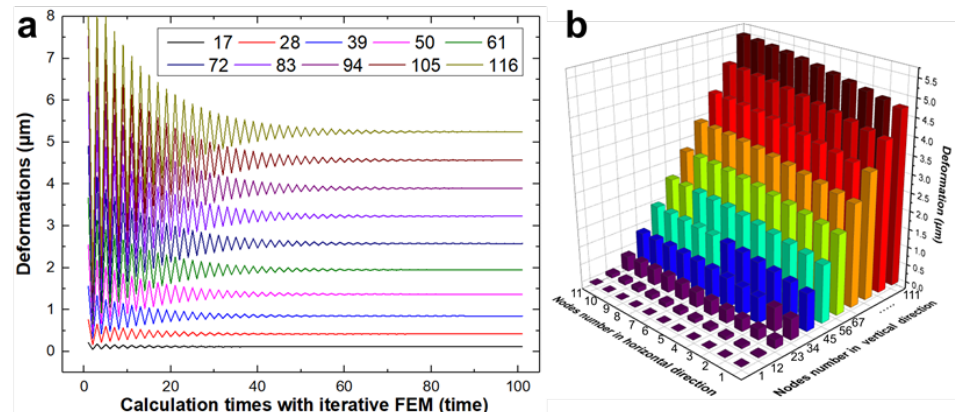
Figure 8. ( a ) Deformations of parts nodes in the iterative calculation process; ( b ) all node deformations in horizontal and vertical direction.